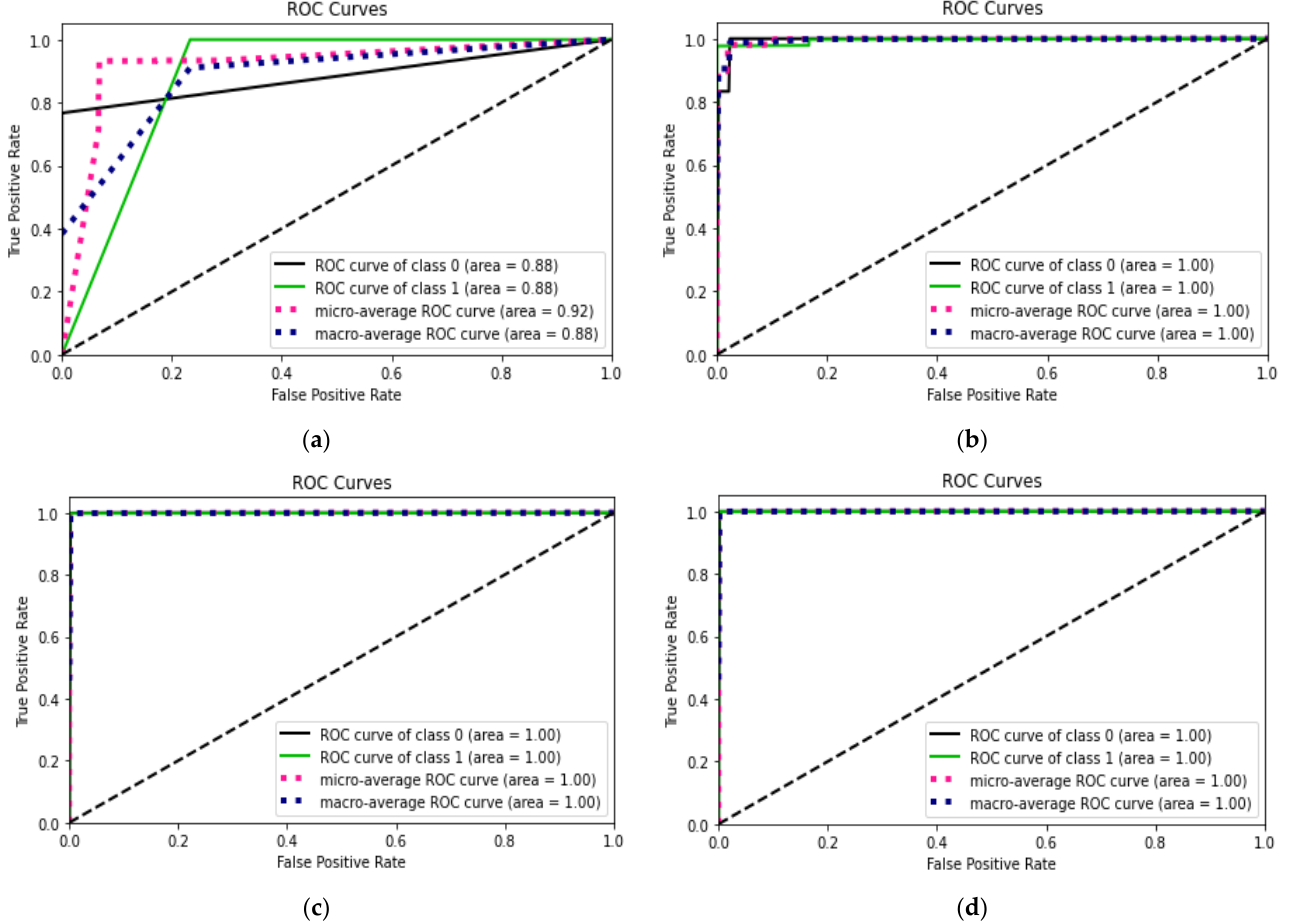
Figure 4. ROC curves for each experiment in Table 7. ( a ) Training with datasets 2 + 4 + 7 and test with dataset 9; ( b ) Training with datasets 2 + 4 + 9 and test with dataset 7; ( c ) Training with datasets 2 + 7 + 9 and test with dataset 4; and ( d ) Training with datasets 4 + 7 + 9 and test with dataset 2.